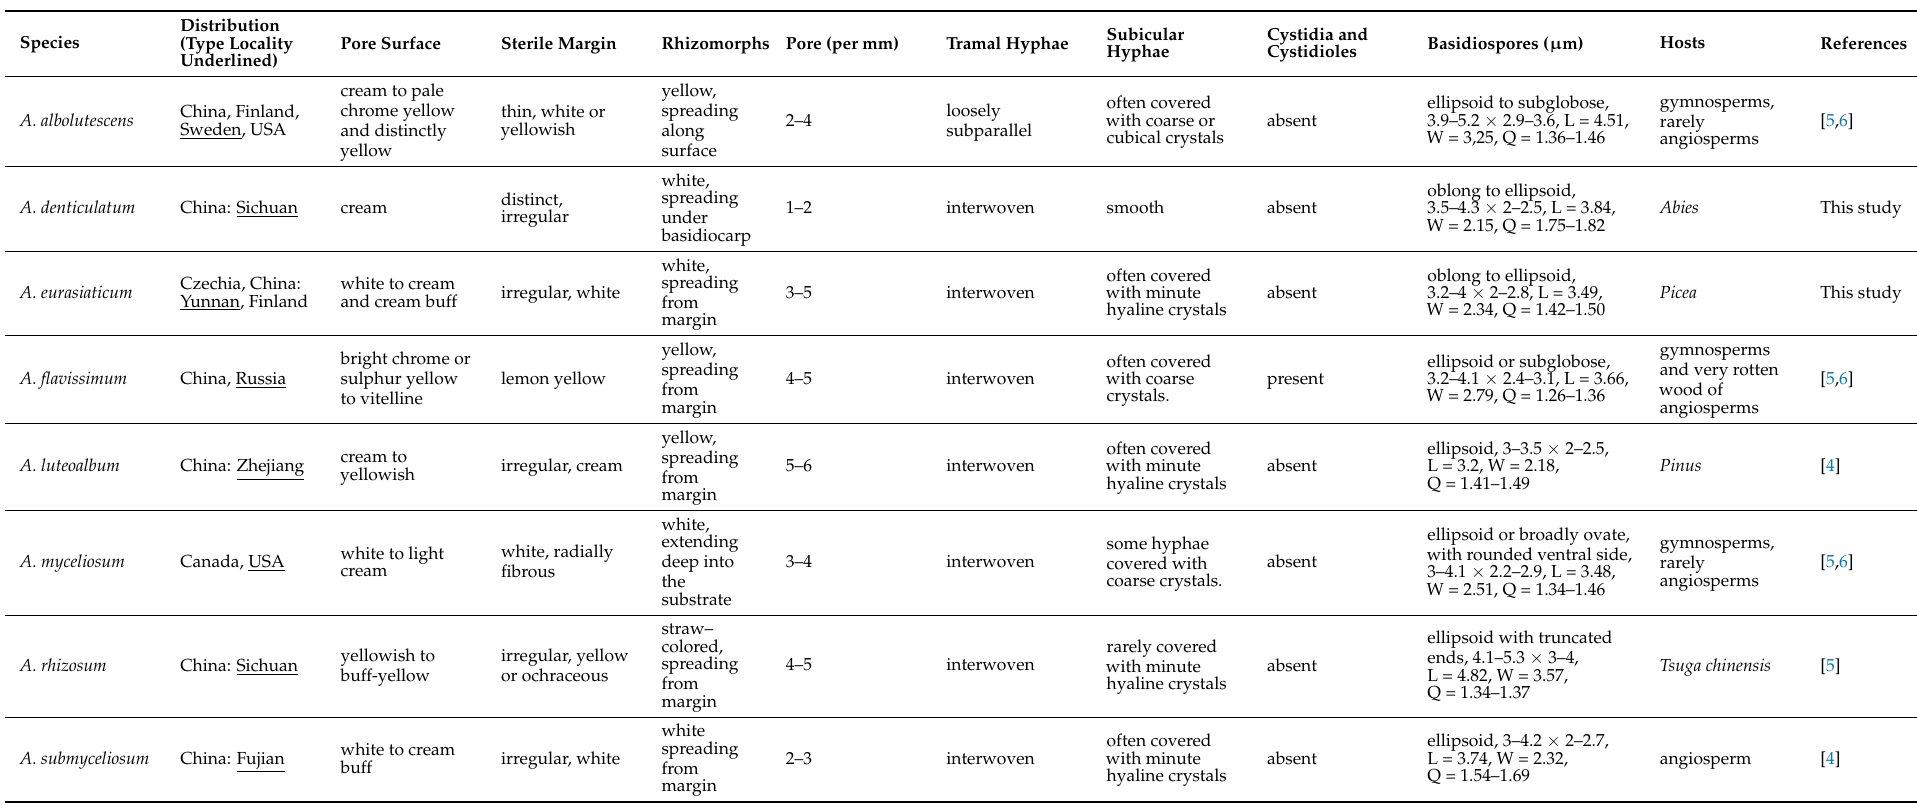
Table 2. A morphological comparison of species in Anomoloma